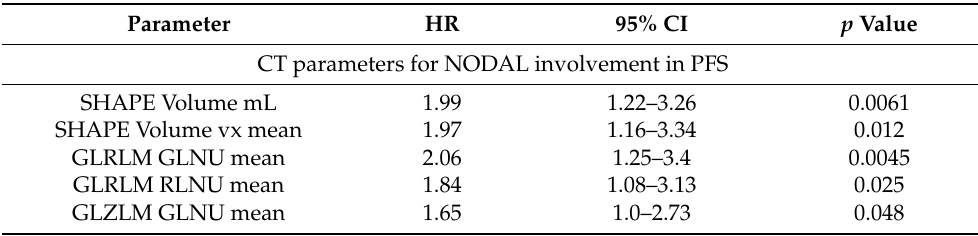
Table 3. Univariate analysis (UVA) summary of statistically significant variables for CT parameters when correlated with PFS and radiotherapy